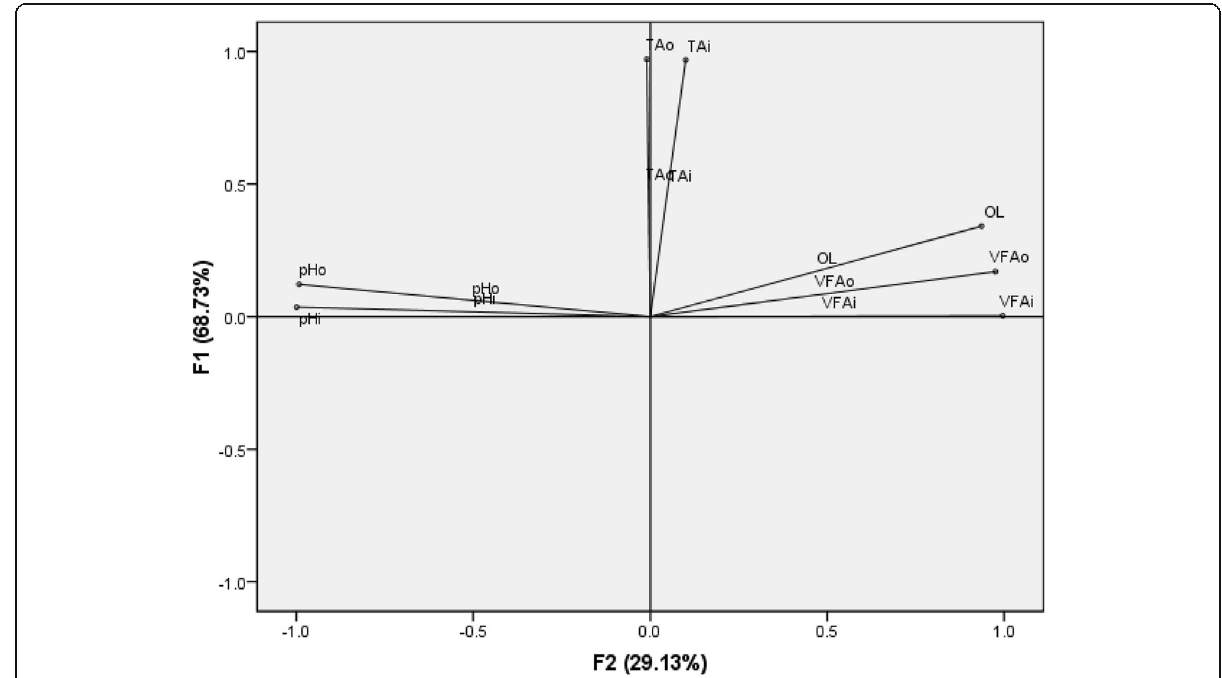
Fig. 5 PCA results of OLs and process parameters